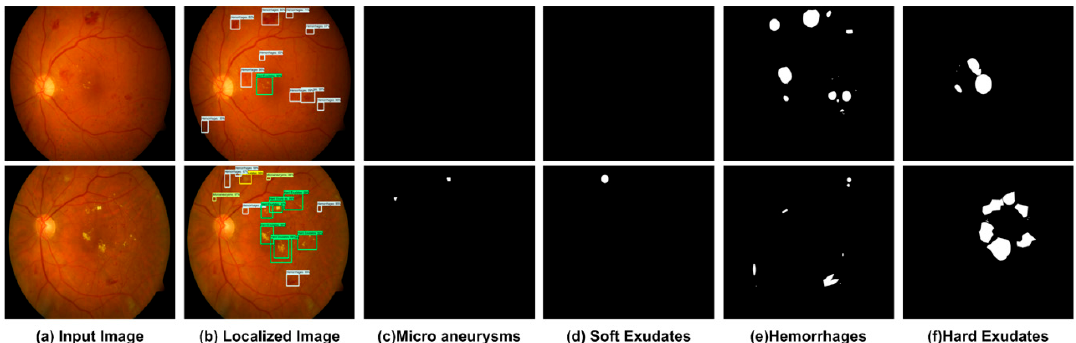
12 of 20 Figure 5. Localization results on test images. Table 4. Glaucoma results. Dataset